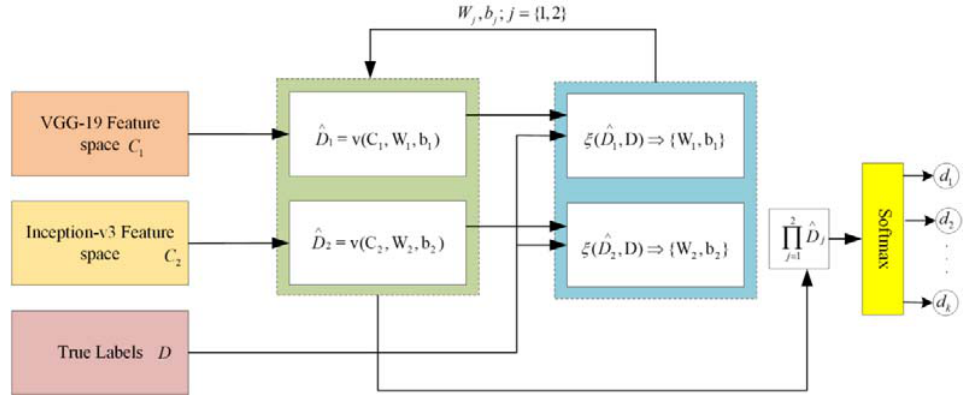
Figure 8. Implementation of feature embedding approach with gradient descent optimizer.